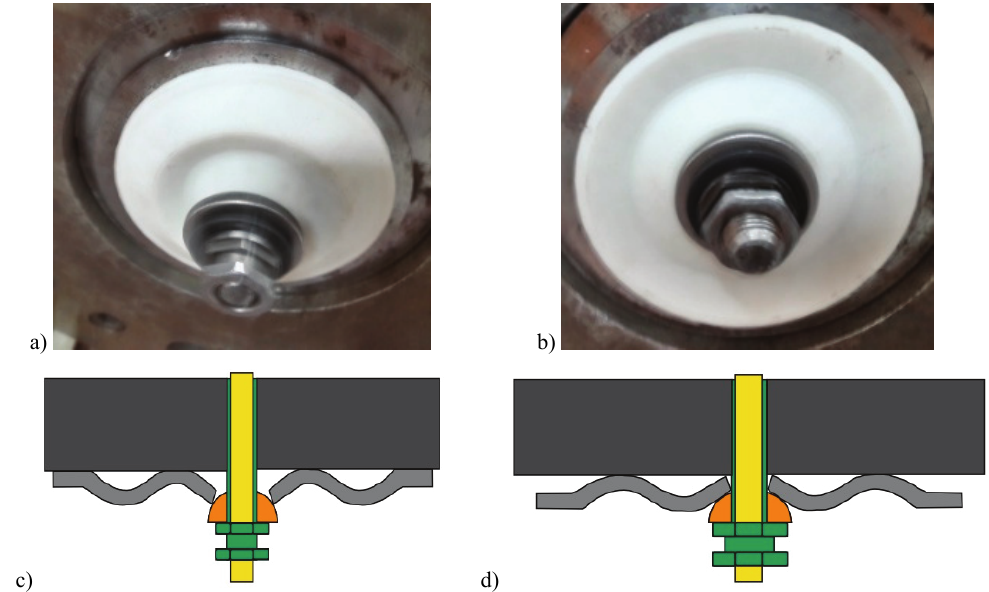
Fig. 9. Settings of the prototype bearing plates: a) correct – general view,